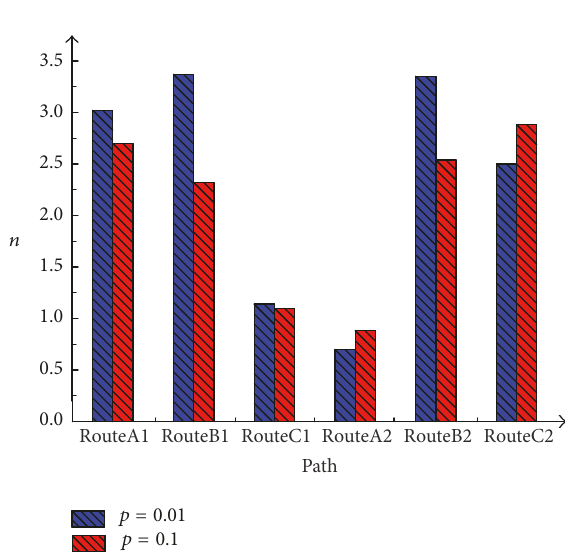
Figure 4: Each path loss index in 28 GHz